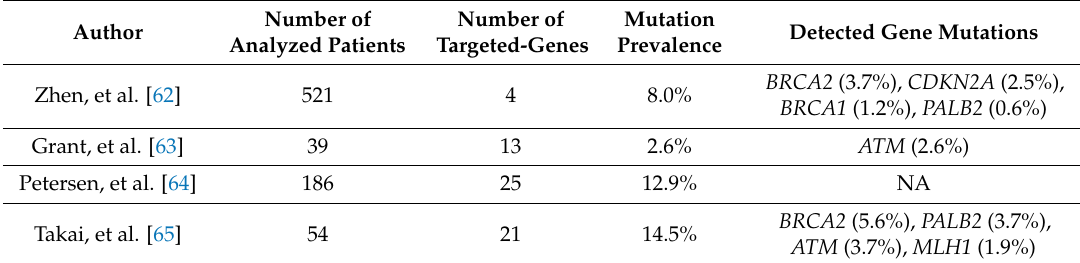
Table 2. Germline mutation analyses for patients with